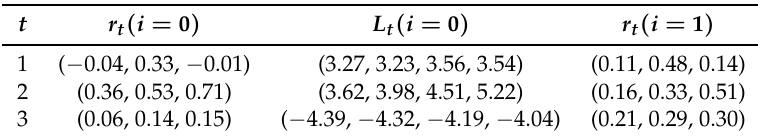
Table A2. Summary of the first update of intermolecular